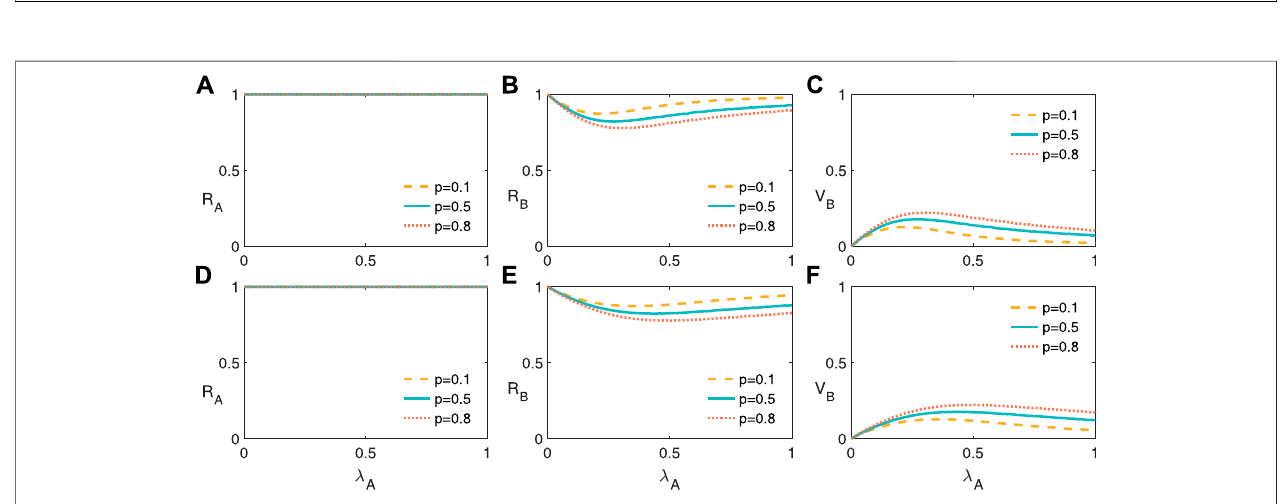
FIGURE 3 | (Color online) The fi nancial risk spreading on two-layer networks for a given values of fi nancial risk transmission probability. Final information spreading size R A (A) , fi nal fi nancial risk spreading size R B (B) , and vaccination size R B (C) versus information transmission probability λ A with fi nancial risk transmission probability λ B =0.5. R A (D) , R B (B) ,and R B (C) versus and φ =